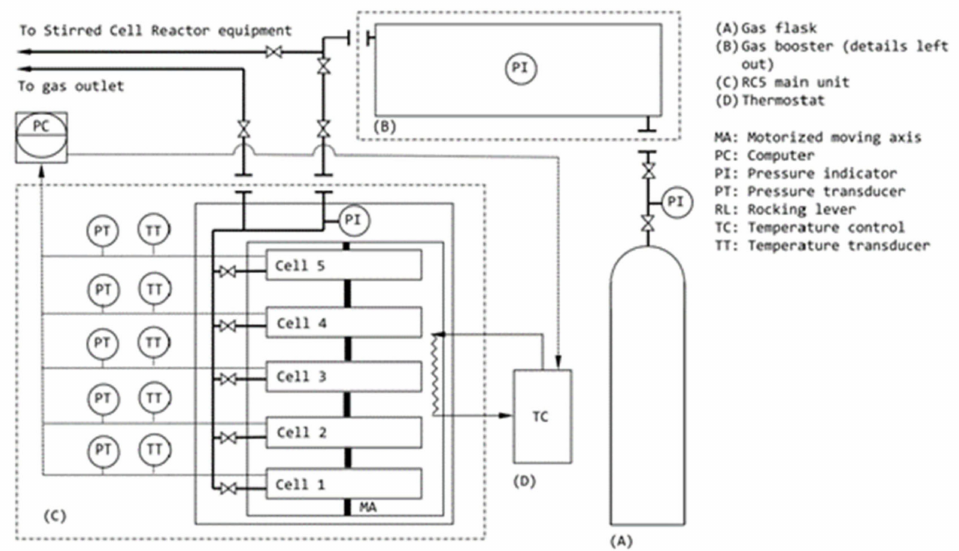
Figure 4. Schematic diagram of the Rocking Cell-5 apparatus (adapted from